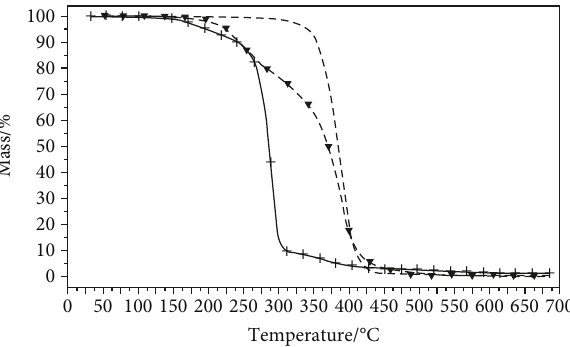
Figure 11: MTGA curves of linear PCL homopolymer and SCL# and HEMACL# copolymers. Symbols: ( − ) linear PCL, ( + ) SCL4, and ( ▼ )